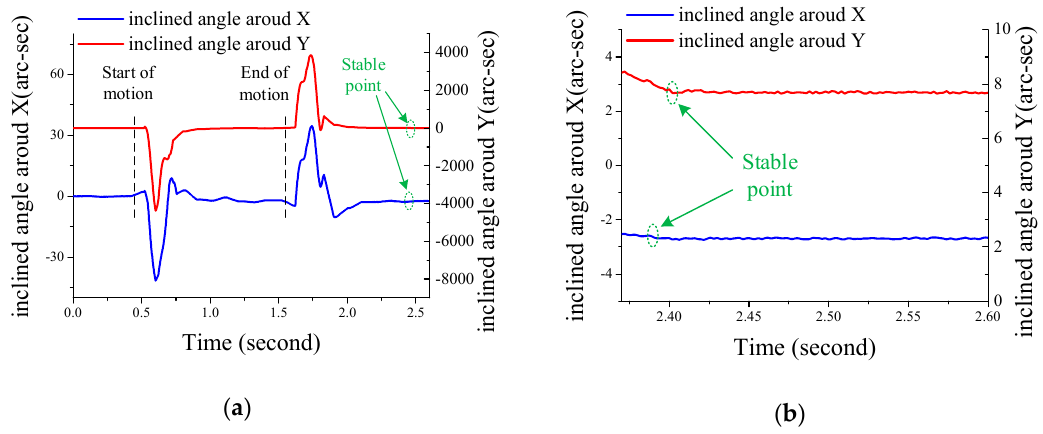
Figure 10. The response time of the proposed precision level: ( a ) all the response raw data; ( b ) partial view.